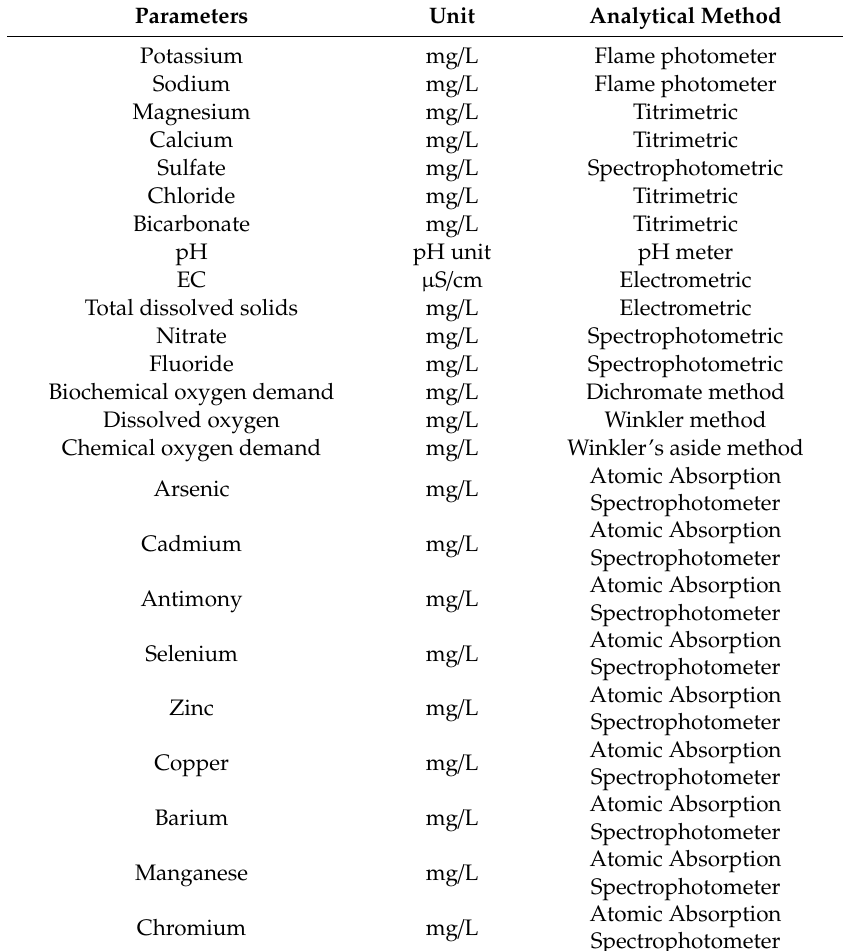
Table 1. Water quality parameters, associated units, and analytical method